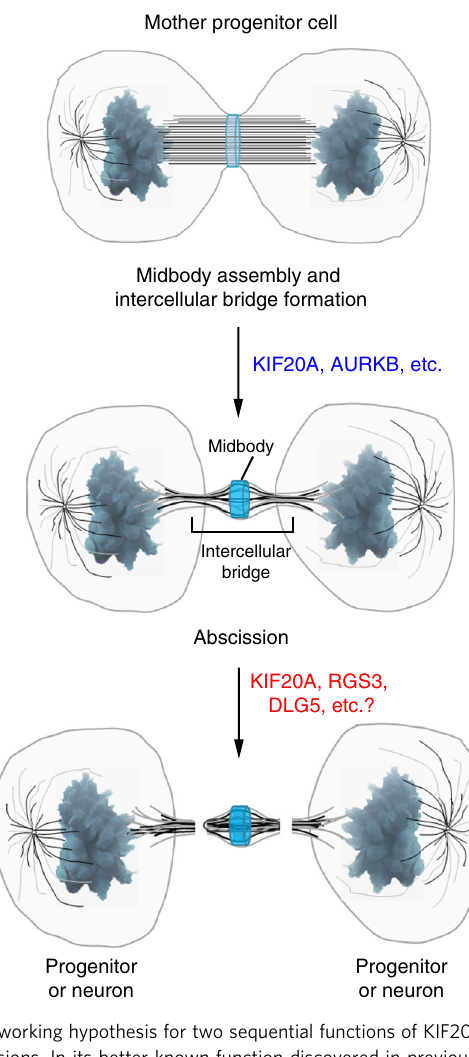
Fig. 9 A working hypothesis for two sequential functions of KIF20A during NPC divisions. In its better known function discovered in previous studies 30, 31 , KIF20A is involved in the assembly of the midbody, for example, facilitating translocation of Aurora B (AURKB) into the